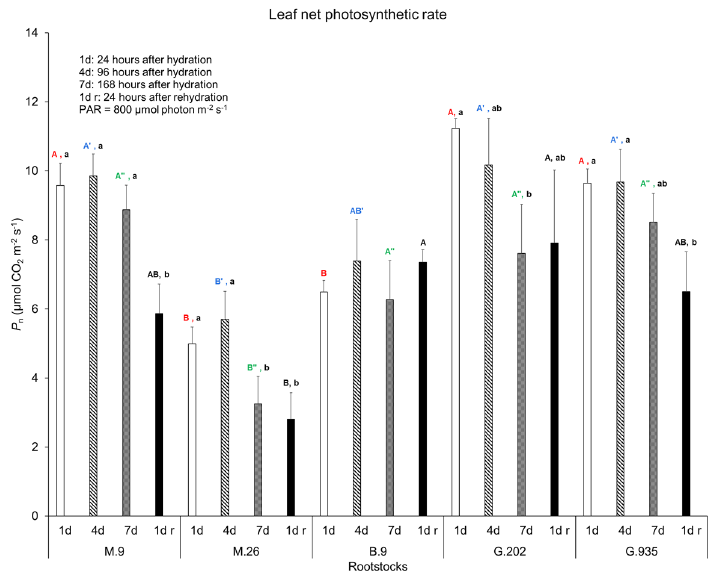
Figure 1. Leaf net photosynthetic rate of Ambrosia TM scion on five rootstocks in the greenhouse water deficit experiment. Bars and error bars are the mean and standard error ( n = 6). Different uppercase letters in the same color indicate significant differences amongst rootstocks on each day (red, blue, and green for Day 1, Day 4 and Day 7 after irrigation, respectively; black for one day after rehydration) ( P ≤ 0.05, ANOVA, Fisher LSD pairwise comparisons). Different lowercase letters in each rootstock indicate significant day-to-day variations ( P ≤ 0.05, ANOVA, Fisher LSD Pairwise Comparisons).